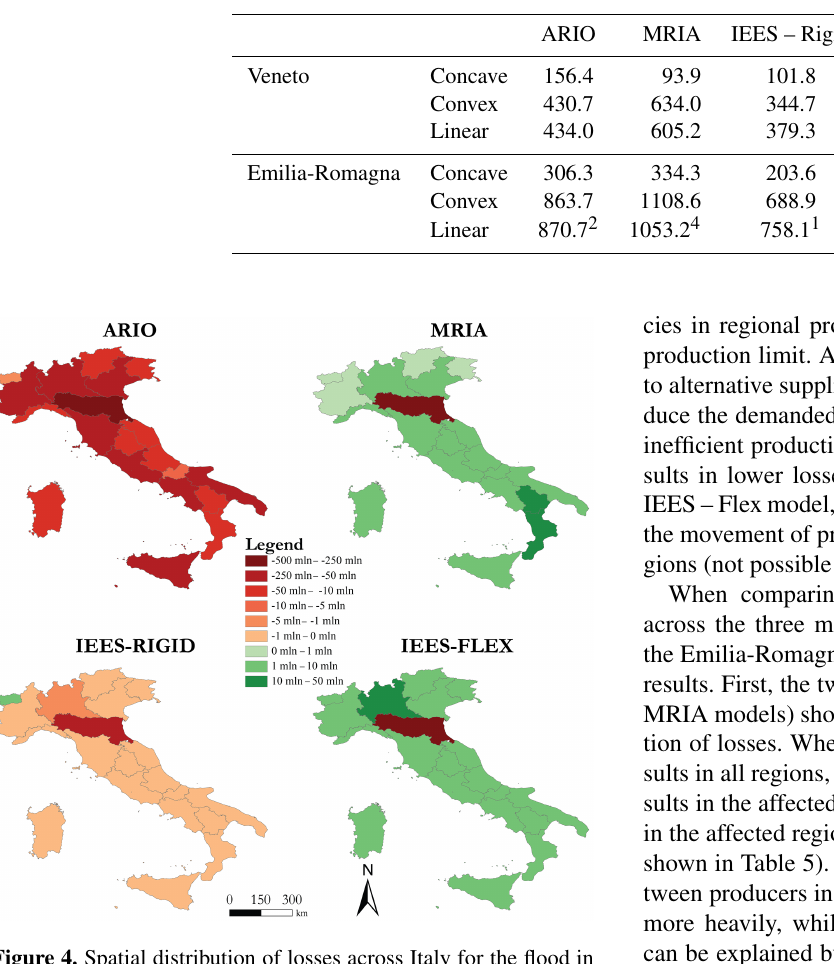
Figure 4. Spatial distribution of losses across Italy for the flood in Emilia-Romagna with the concave reconstruction curve for the four model